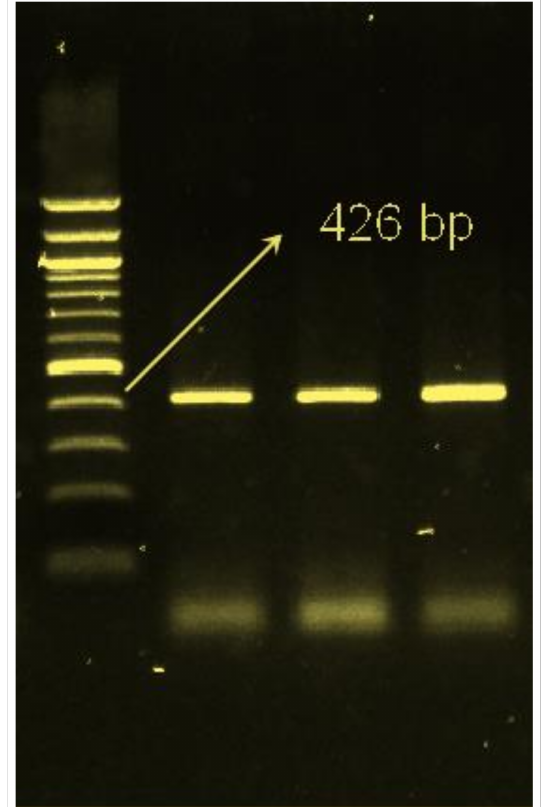
Figure 1. PCR product of the CLPG mutation (426 bp) visualized using 1.5%